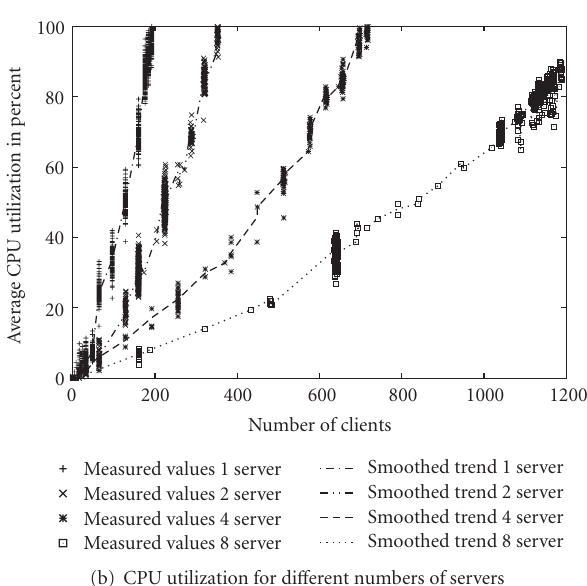
Figure 16: RTFDemo: the fast-paced evaluation game and the results of the